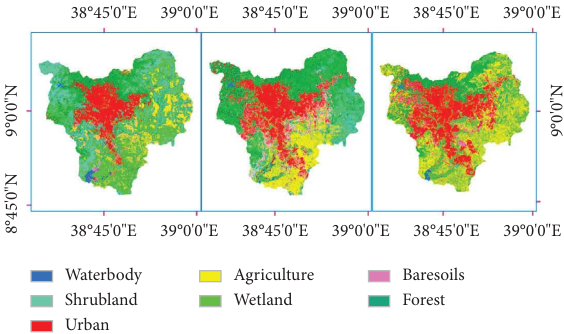
Figure 3: Land use and cover maps for 2000, 2010, and